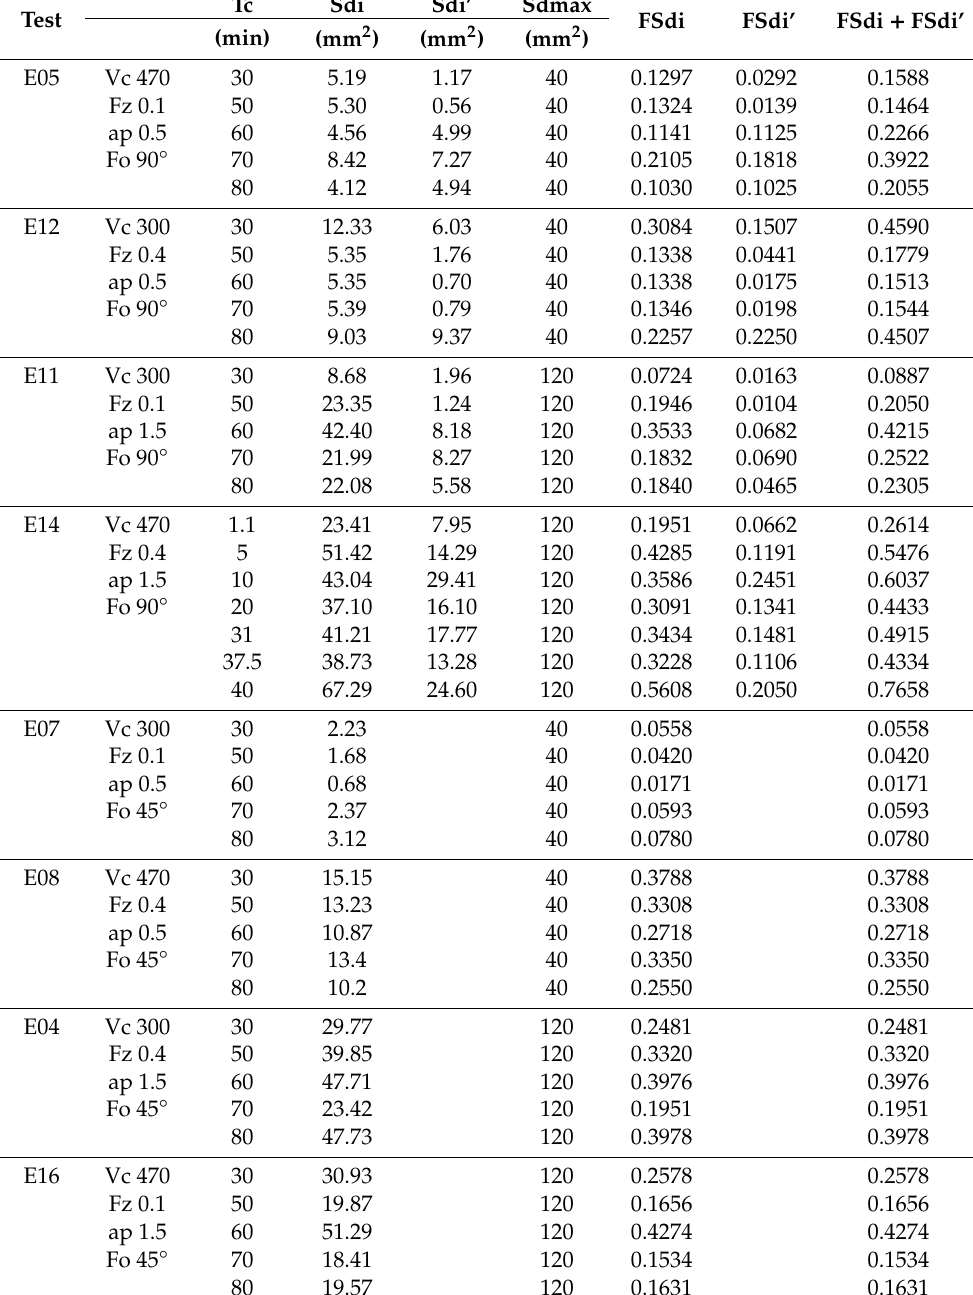
Table 9. Area parameters in Type II